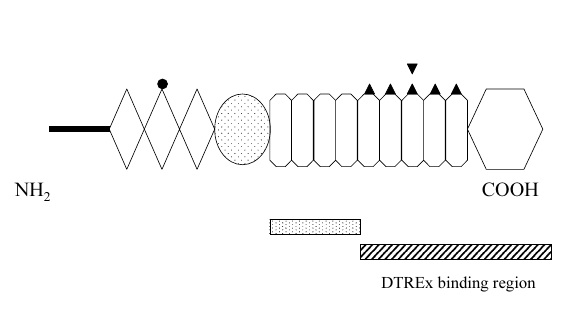
Figure 3 Diagrammatic representation of the human fibulin-1C pro- tein (modified after Argraves et al. [33]). Note that for the derived amino acid sequence obtained for the monkey fibu- lin-1C protein, the human and monkey fibulin-1C proteins have identical structural features. Symbols represent the fol- lowing structural features: anaphylatoxin type I repeats, dia- monds; potential N-glycosylation site, small circle; EGF- adjoining sequence, dotted oval; calcium-binding type II EGF- like modules, open octagons; potential Asn/Asp hydroxyla- tion site, triangles, potential o-glycosylation site, inverted tri- angles; fibulin-type module, large hexagon. The construct insert of pGAD424/Fib-1C EGF #1–5 is represented by a dotted box. The construct insert of pGAD424/Fib-1C EGF #5-COOH, containing a region of fibulin-1C that interacts with the extracellular domain of monkey proHB-EGF (DTREx), is represented by a forward slashed